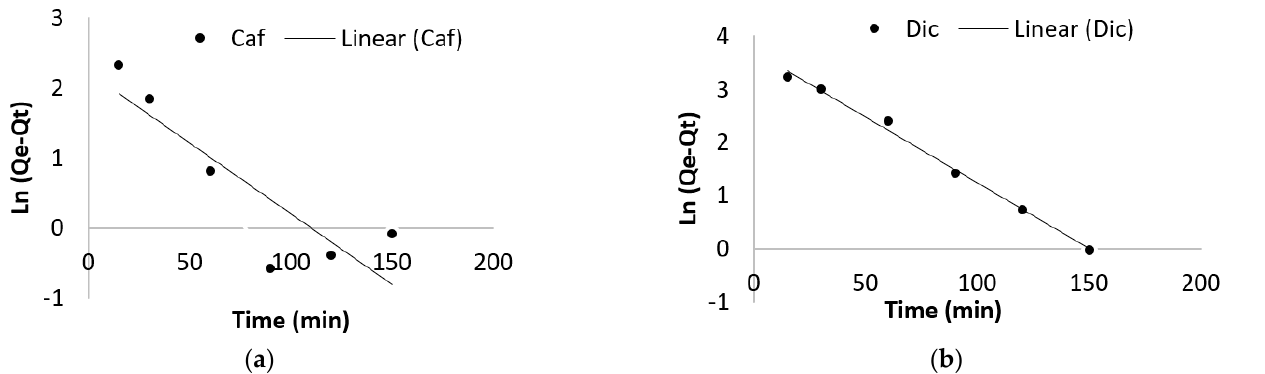
Figure 7. Pseudo-first-order kinetic model applied to the adsorption of Caf ( a ) and Dic ( b ) on activated carbon from argan nutshells.